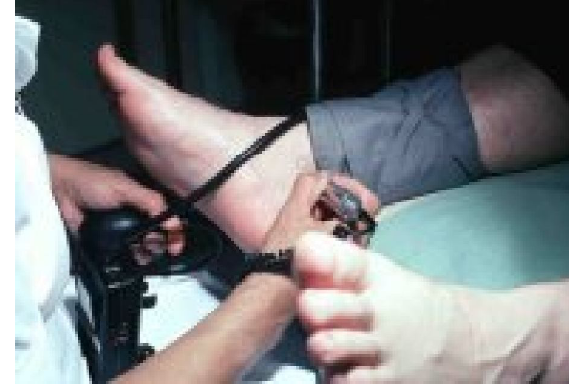
Figure 9b. Posterior tibial artery